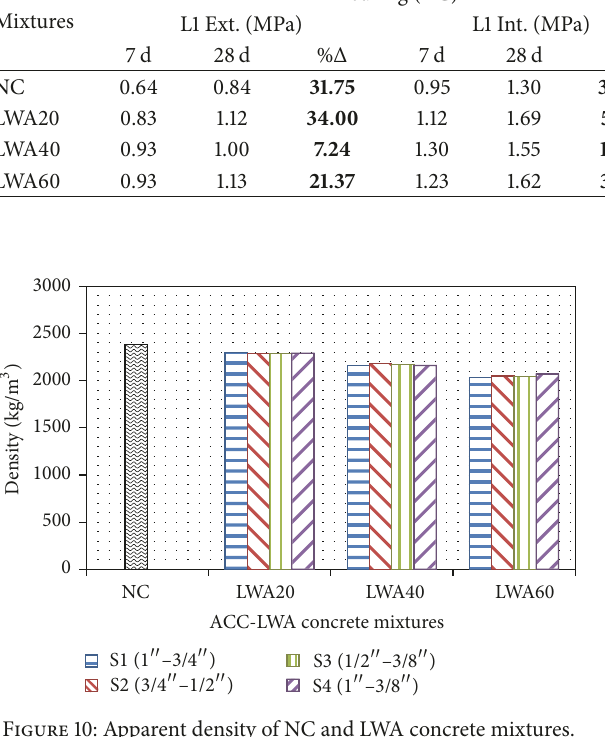
Figure 10: Apparent density of NC and LWA concrete